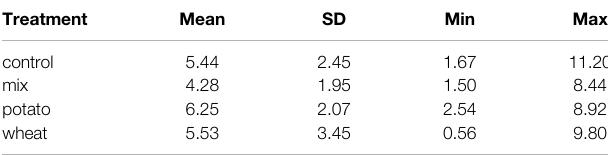
TABLE 1 | Summary statistics for bio fi lm dry-weights (in mg) by treatment. Treatment